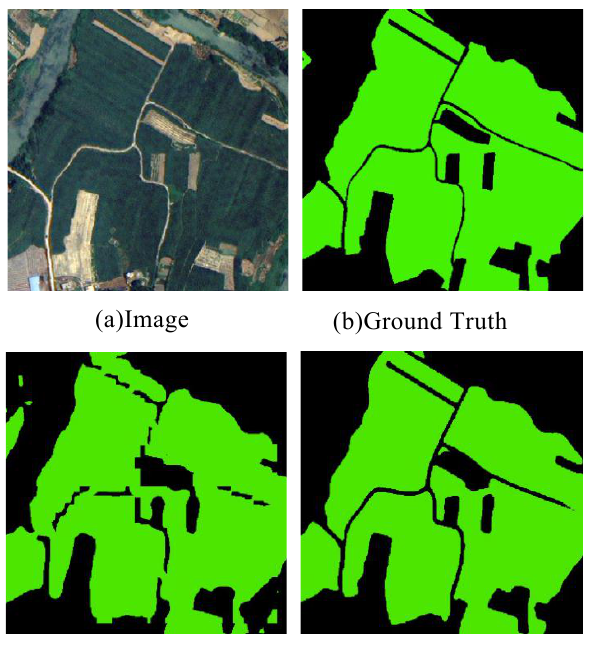
Figure 10. Accuracy curve